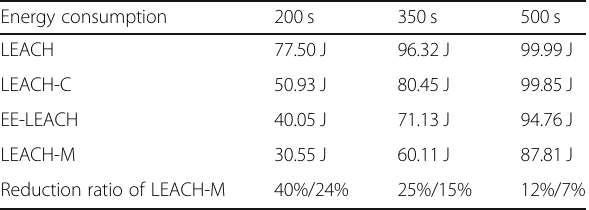
Table 7 The statistics of energy consumption of four algorithms in 300 × 300m 2